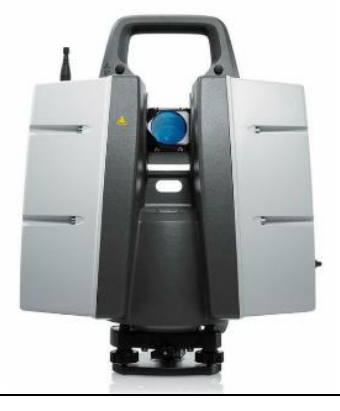
Figure 10. Leica P30 laser scanner.